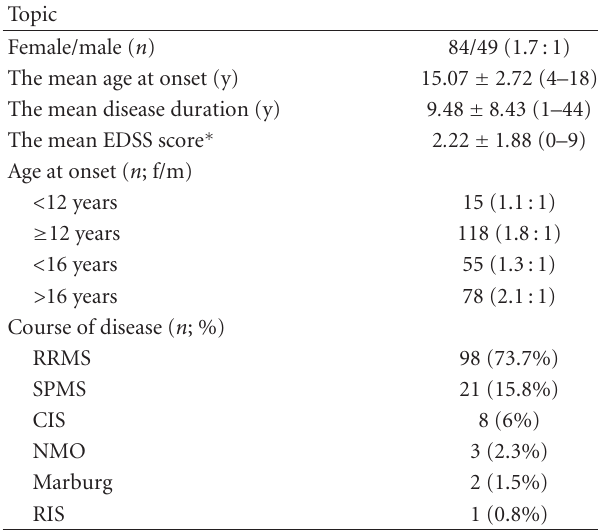
Table 1: Clinical and demographic features of the 133